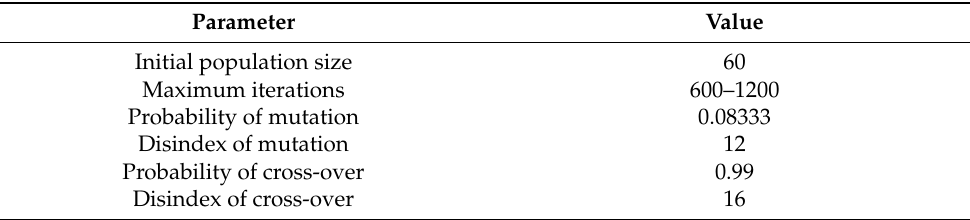
Table 2. NSGA-II user adjustable parameters’ set